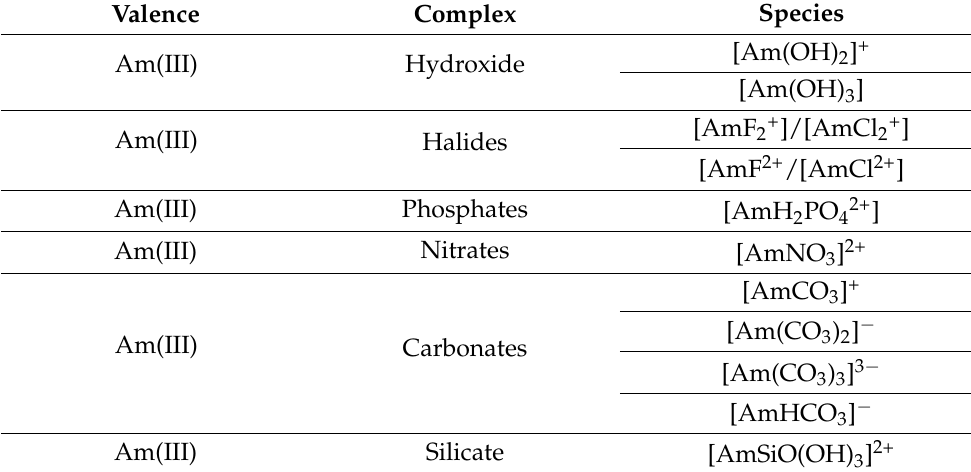
Table 10. Summary of soluble species of Am in natural